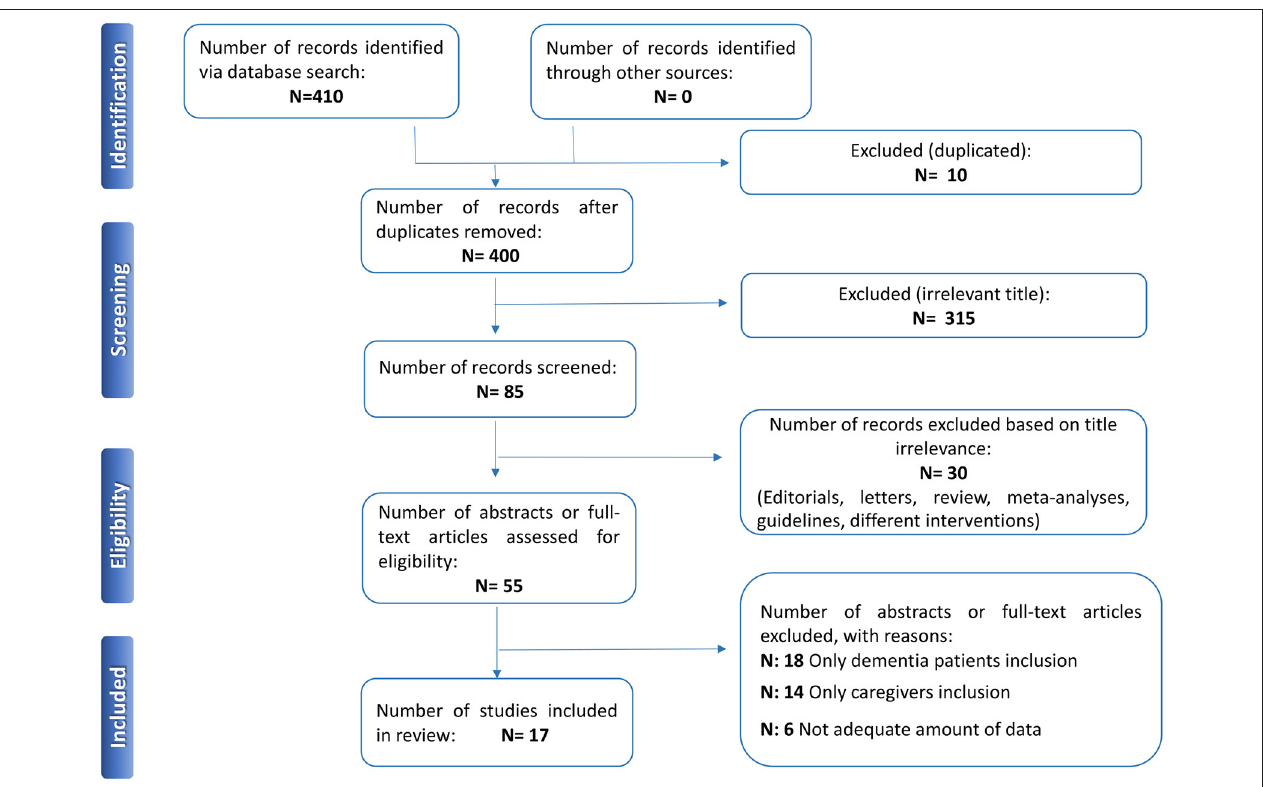
FIGURE 1 | PRISMA flow-chart. PRISMA, preferred reporting items for systematic reviews and meta-analyses.